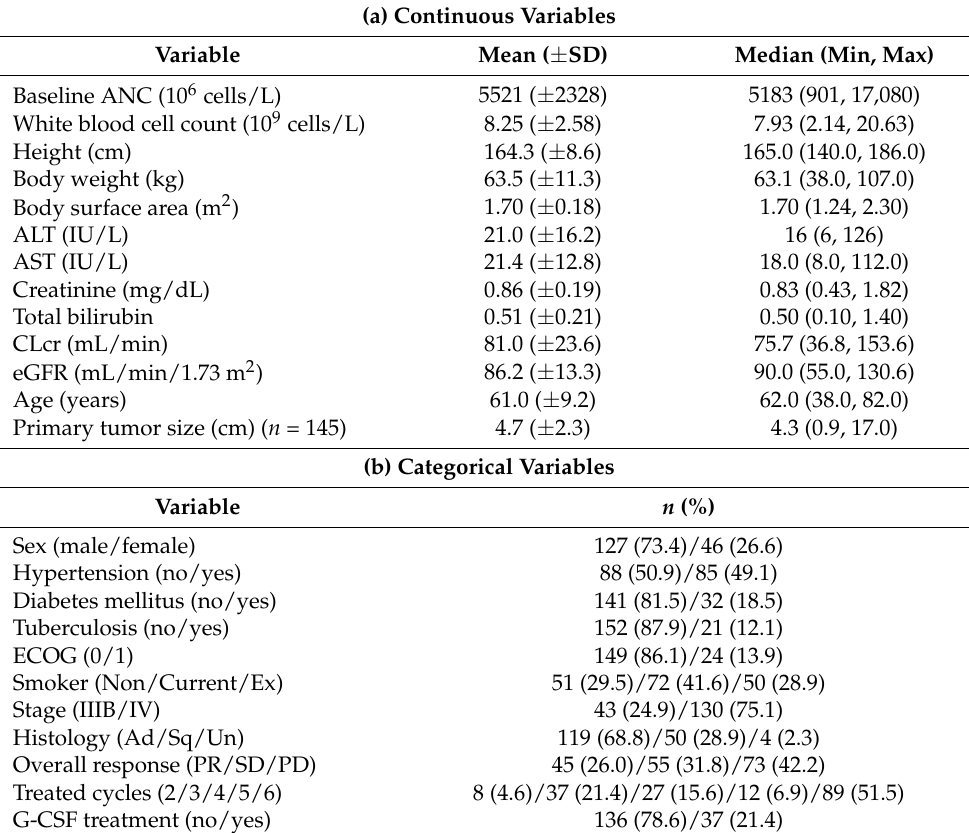
Table 1. Patient demographic